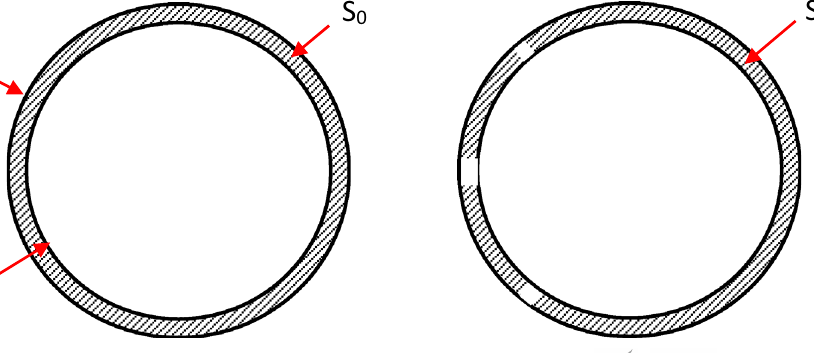
Fig. 11 Cross-sectional area of base pipe before and after perforated